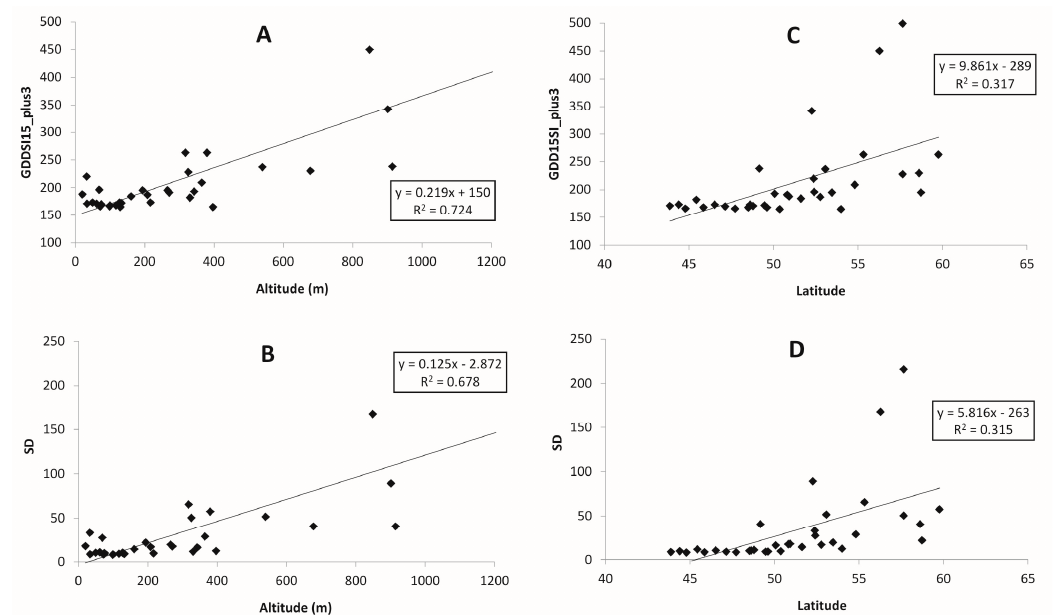
Figure 5. Dependence of Sensitivity Index for growing degree days with 0 °C threshold (GDD0SI) and its standard deviation (SD) for a GDD0 +3 scenario on altitude and latitude for continental locations in the Russian Far East for the period 1966–2017: ( A , B ) altitude (m), ( C , D ) latitude.